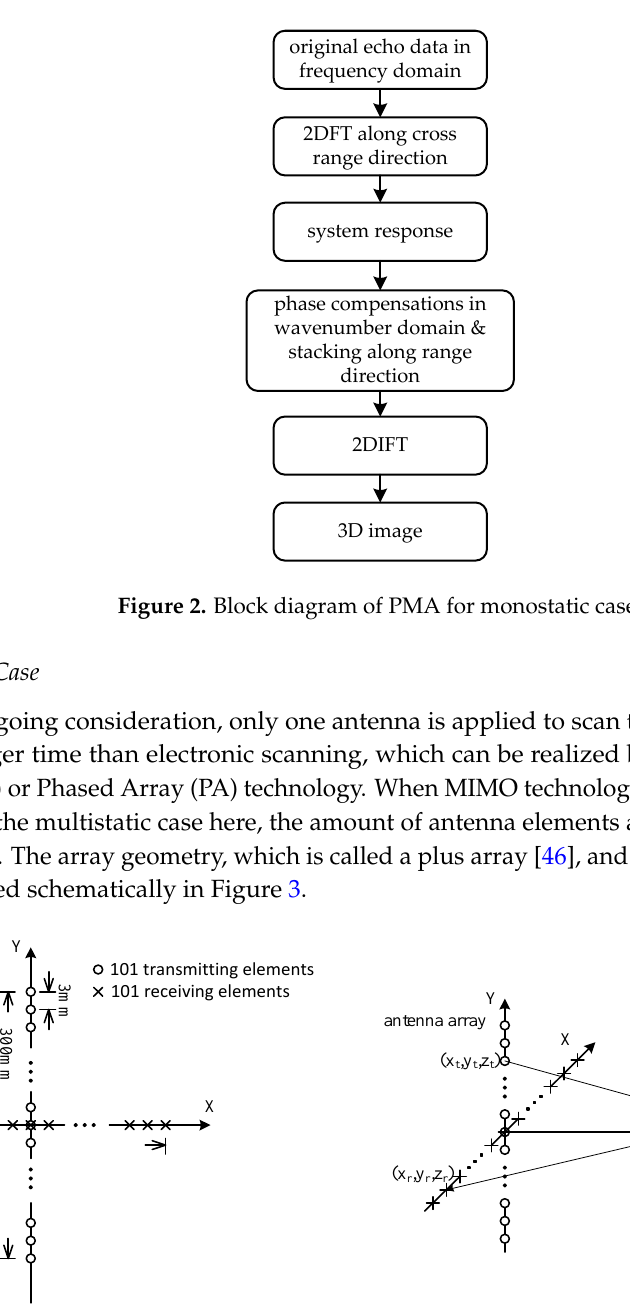
Figure 3. The array geometry and the setup of the experiment for multiple input and output elements: ( a ) the plus array geometry; ( b ) the setup of the experiment.